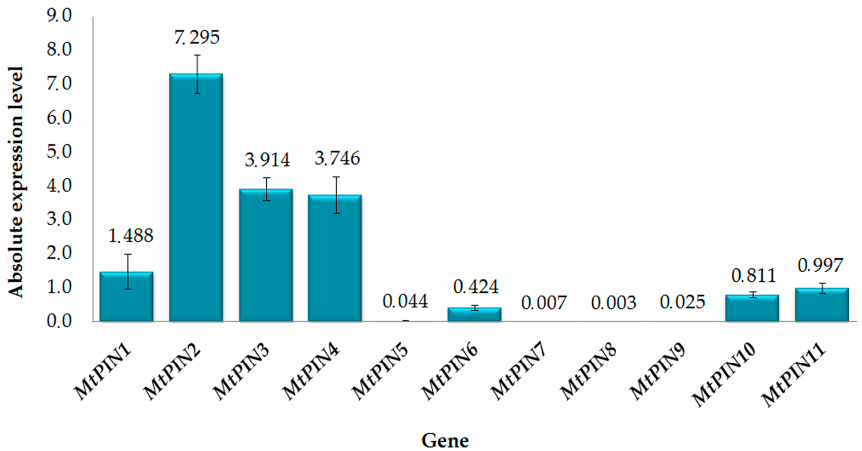
Figure 1. Absolute, normalized level of PIN expression in M. truncatula root tips. Mean values (±SE) are derived from two biological replicates, for which three individual qPCR reactions were performed ( n = 6). Expression level for each PIN was normalized to the endogenous control.